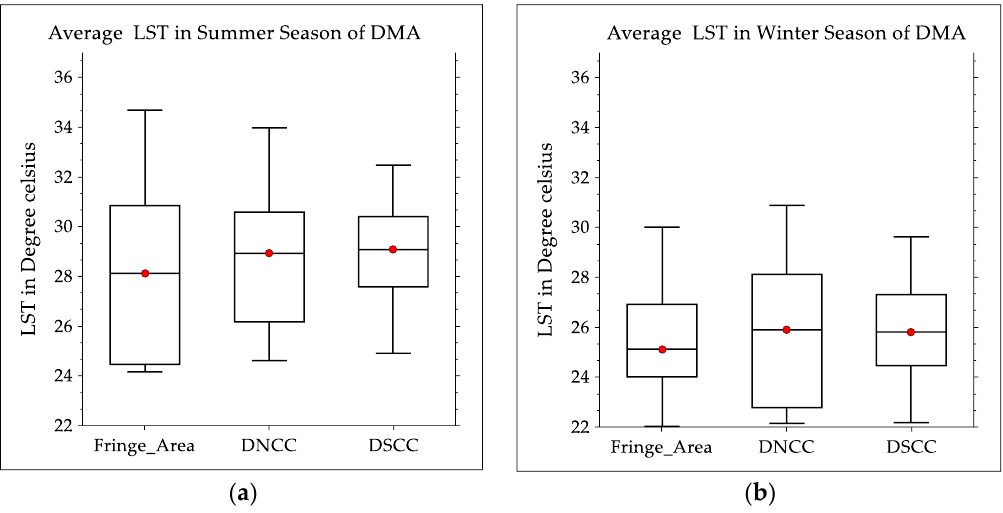
Figure 15. ( a ) Average LST in the summertime and ( b ) average LST in the wintertime of DMA.